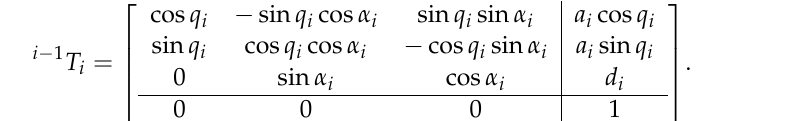
spring-balancer mechanism, (b) Gravity compensation using counterweight mechanism. spring–balancer mechanism; ( b ) gravity compensation using counterweight